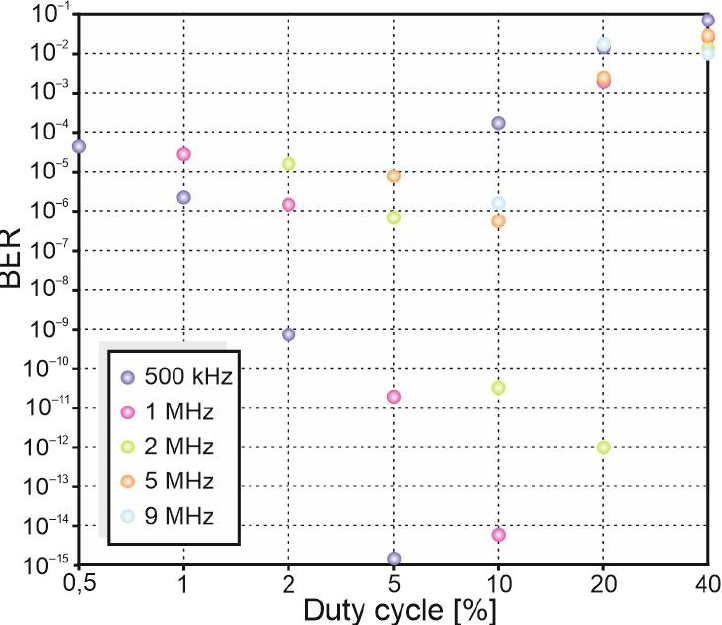
Figure 7. BER values for different pulse duty factors and frequencies at the laser operating temper- ature of −10 °C.